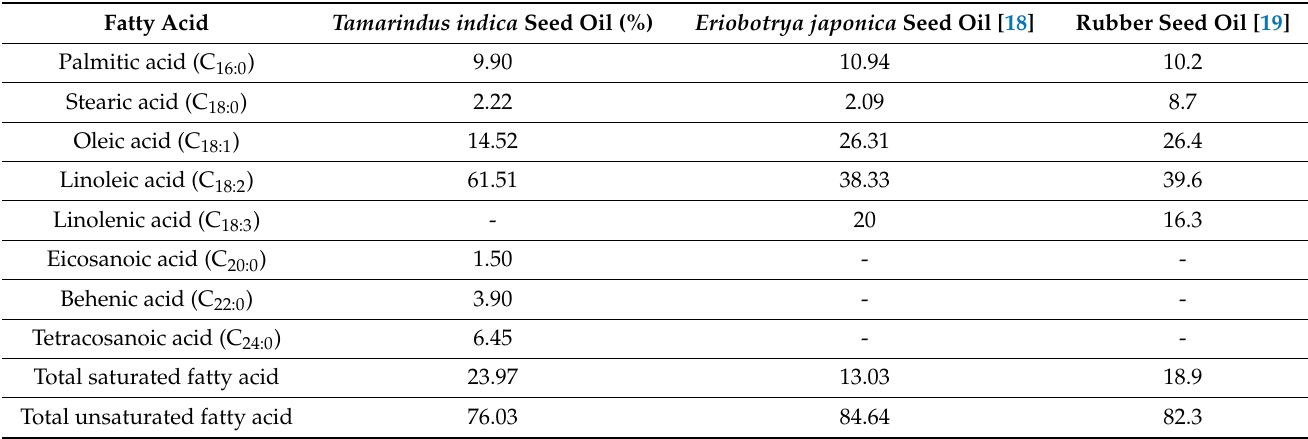
Table 4. Fatty acid profile of T. indica seed